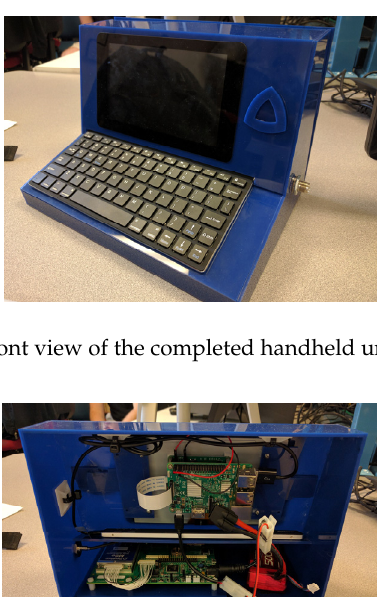
Table 1. Inclusive bill of materials for all materials used to construct the prototype unit.